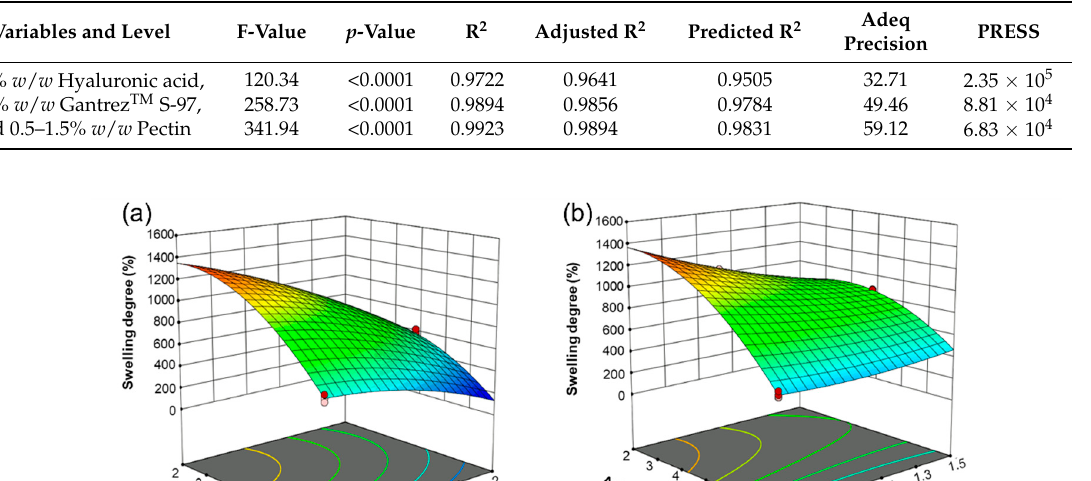
Table 1. Fit statistics of the